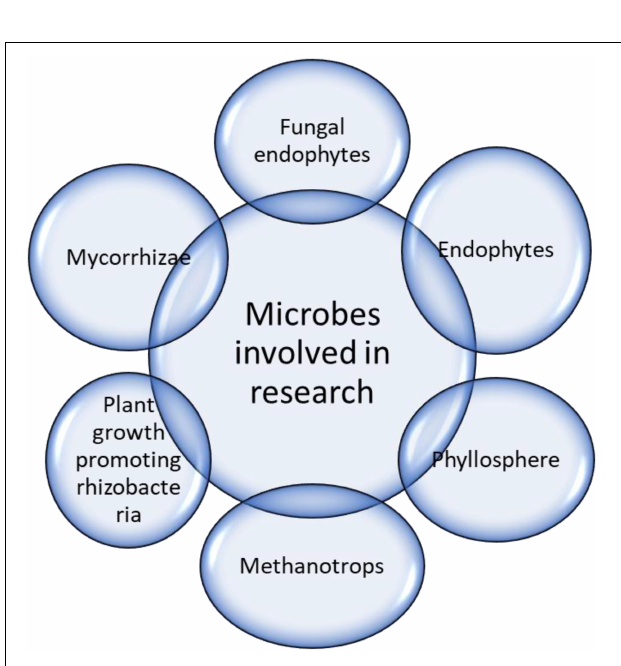
FIGURE 4 | Microbes involved in drought stress